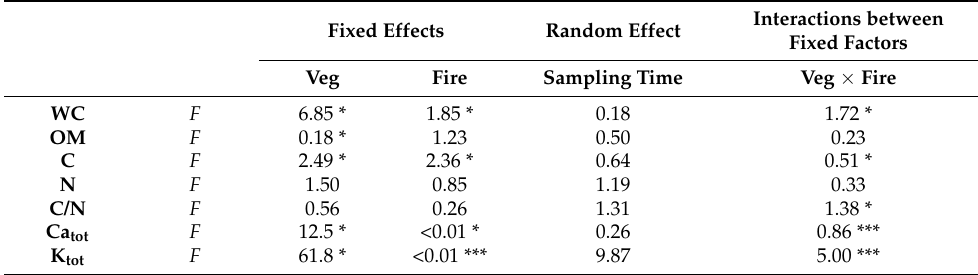
Table 4. Summary of mixed-effect model analyses (F-value: F ) between vegetation cover type